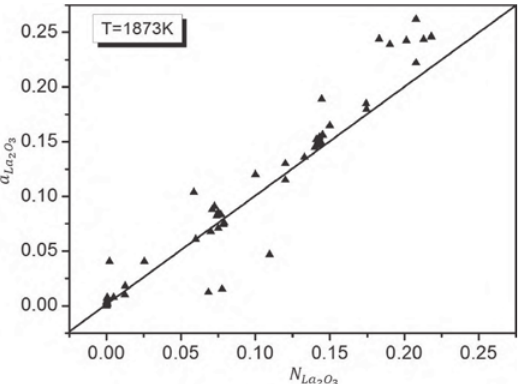
Fig. 2: The comparison of calculated mass action concentration of La 2 O 3 and measured activity of La 2 O 3 in La 2 O 3 -Al 2 O 3 -CaF 2 ternary slag system at 1873 K